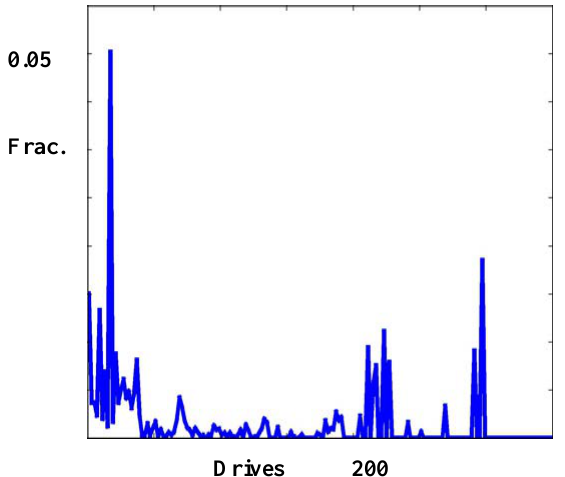
Figure 1. Observed fraction of malware versus number of drives on which a hash value appears. Highest peak is 0.08 at 16